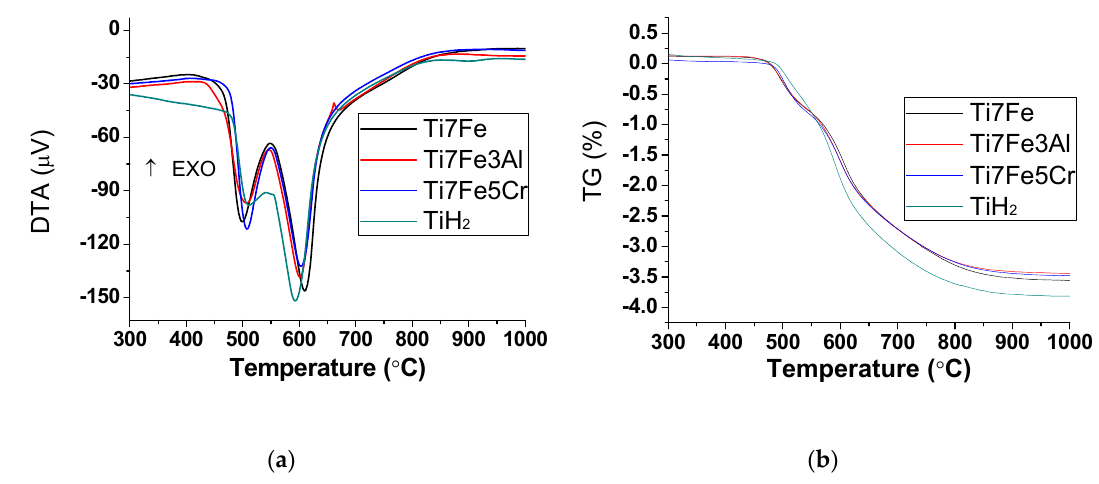
Figure 3. DTA ‐ TG curves for the Ti alloys blended powders (a) DTA and (b) TG . Figure 3. DTA-TG curves for the Ti alloys blended powders (a) DTA and (b) TG. Table 2. Onset and o ff set parameters from the two-step reaction of hydrogen decomposition. Table 2. Onset and offset parameters from the two ‐ step reaction of hydrogen decomposition